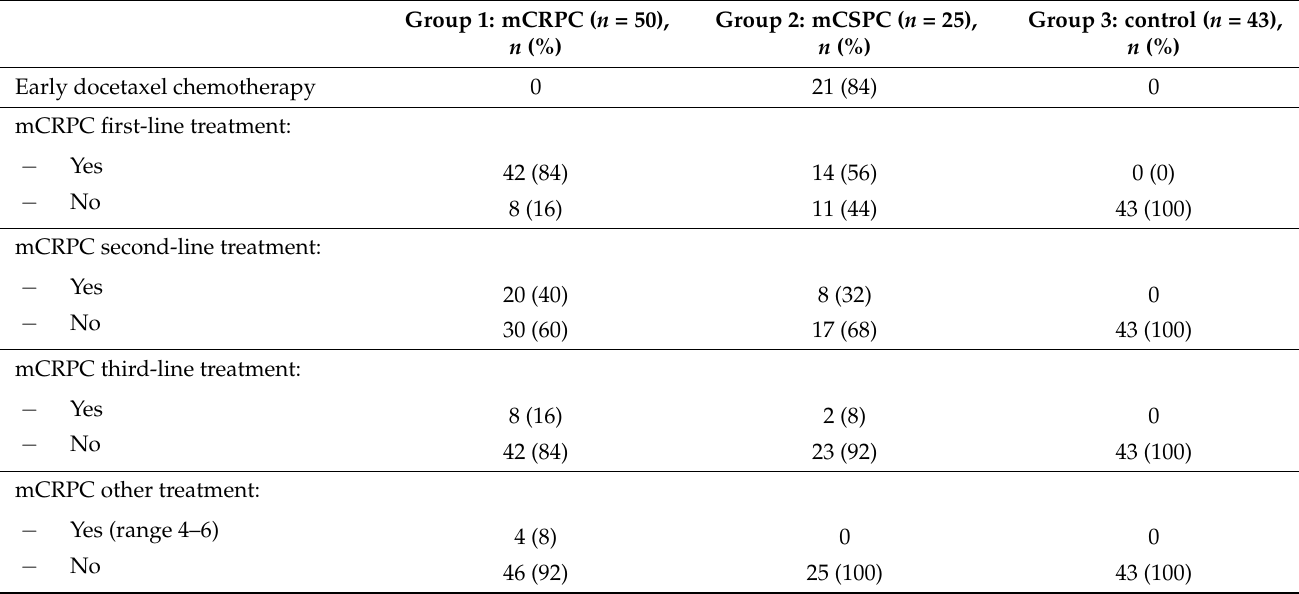
Table 5. Treatment and clinical outcomes in patients with and without a cribriform pattern in the histologically reviewed